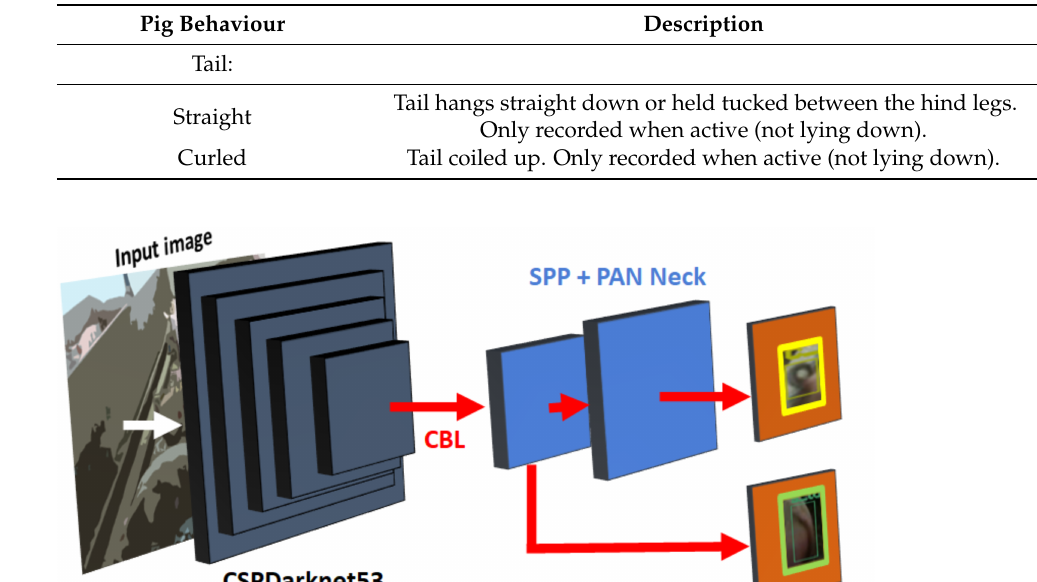
Table 2. Description and definition of straight and curled tail labelling for YOLOv4 tail detection.